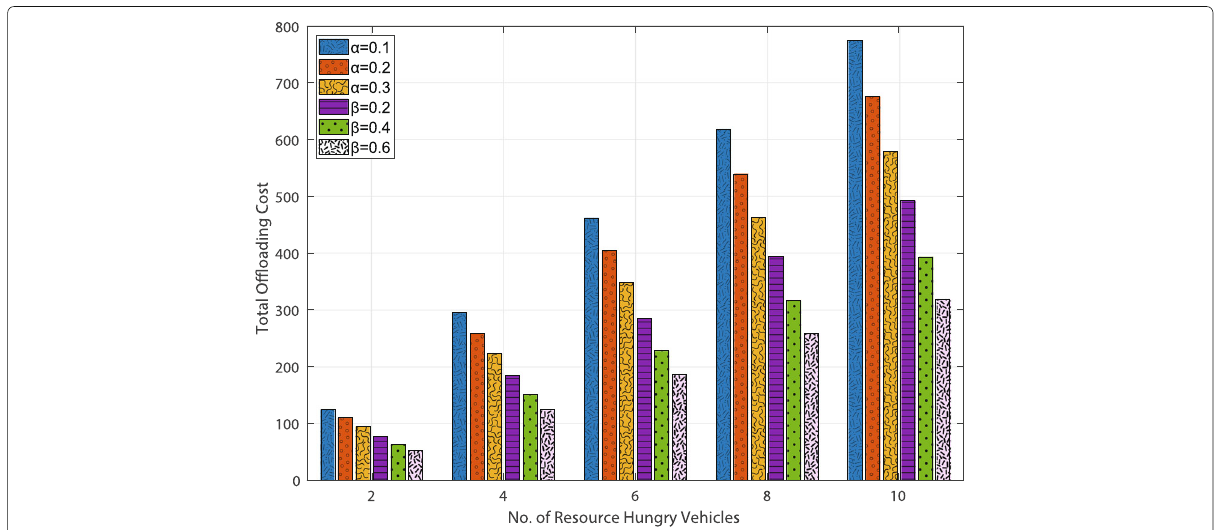
Fig. 4 The total offloading cost with fixed values of α n and β n , when RRVs=10